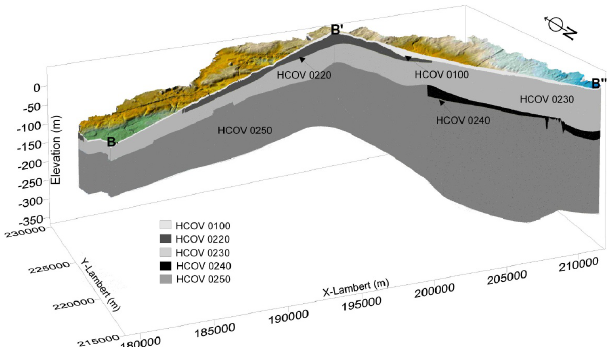
Fig. 4. Conceptual overview of the applied spatial-temporal methodology. The figure shows a watershed discretized using a rec- tilinear grid, surface water bodies are represented in blue. For ev- ery cell all water balance components are simulated daily and the runoff, interflow and groundwater flow are routed to the outlet of the catchment. Recharge and discharge are aggregated to half-monthly time steps. Two cells in this figure are highlighted. Cell A represents a typical groundwater discharge area: during most time steps the groundwater in this cell flows from the groundwater system towards the land surface where the groundwater can discharge to the surface water bodies or be used for evapotranspiration. Cell B represents a typical recharge area where the water table is recharged by water infiltrating from the land surface. The graphs on the right show how the groundwater discharge or recharge flux typically evolve over time. In this study the groundwater system is simulated for the ref- erence condition (grey line) and several climate change scenarios (e.g. orange